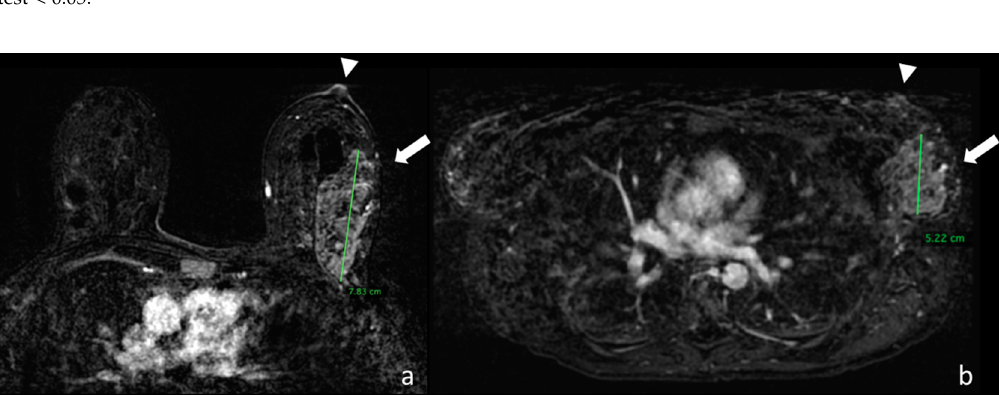
Figure 3. ( a ) Image taken from the first dynamic sequence performed in the prone position showing the nipple area (arrowhead). At the confluence of the external quadrants of the left breast there is a multicentric pathological impregnation of the contrast medium, which measures around 7.83 cm, which histological analysis identified as a lobular carcinoma infiltrating and in situ (arrow). ( b ) Image taken from the first dynamic sequence performed in the supine position showing the nipple area (arrowhead) in the same patient. At the confluence of the external quadrants of the left breast there is the same multicentric pathological impregnation of the contrast medium, but with a smaller extension of around 5.22 cm.